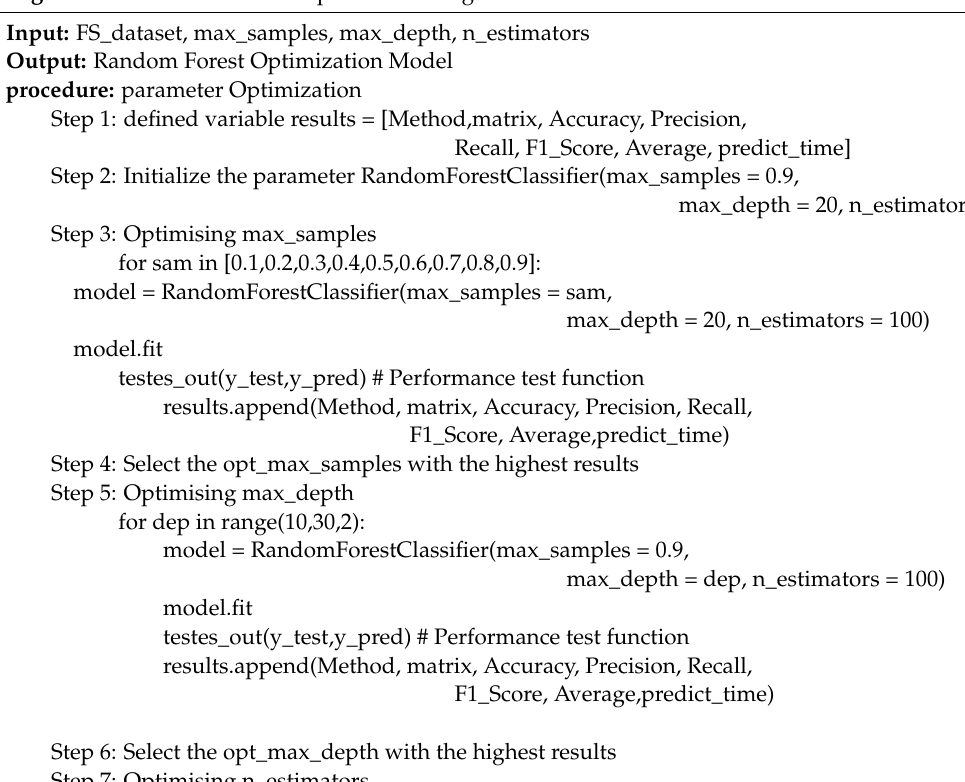
Algorithm 3 : Random Forest Optimization